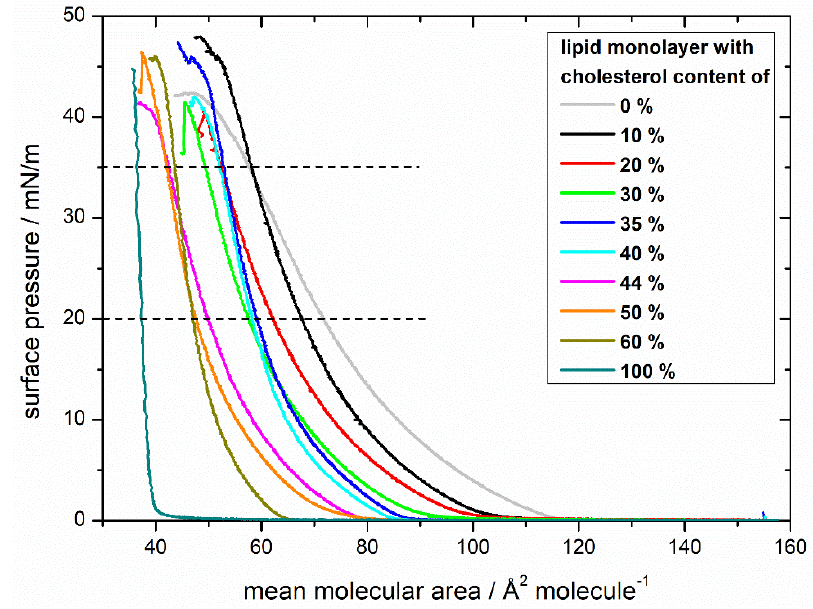
Figure 1. Comparison of compression isotherms of lipid monolayers with differing cholesterol contents. Monolayers have a composition similar to the cytoplasmic leaflet of the myelin sheath with varying amounts of cholesterol (0%, 10%, 20%, 30%, 35%, 40%, 44%, 50%, 60%, 100%) on a N -(2- hydroxyethyl)piperazine- N’ -ethanesulfonic acid (HEPES)-NaCl subphase. The dashed lines at 20 and 35 mN/m visualize the area values used for further analysis.